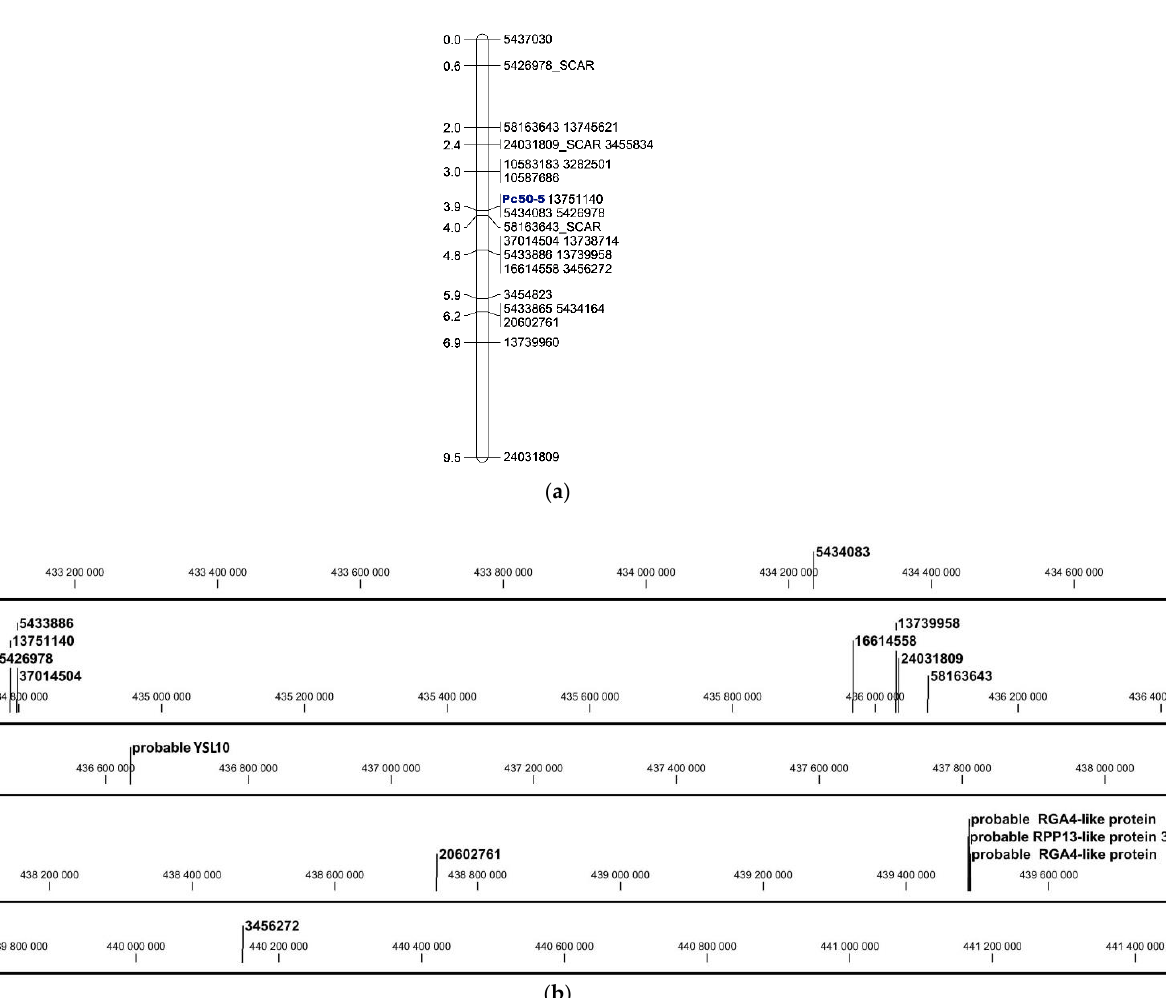
Figure 2. Partial linkage map of markers for Pc50-5 gene ( a ) and its graphical assignment to chromosome 6A of the current version of the oat reference genome ( Avena sativa -OT3098 v2, PepsiCo) [27] ( b ).